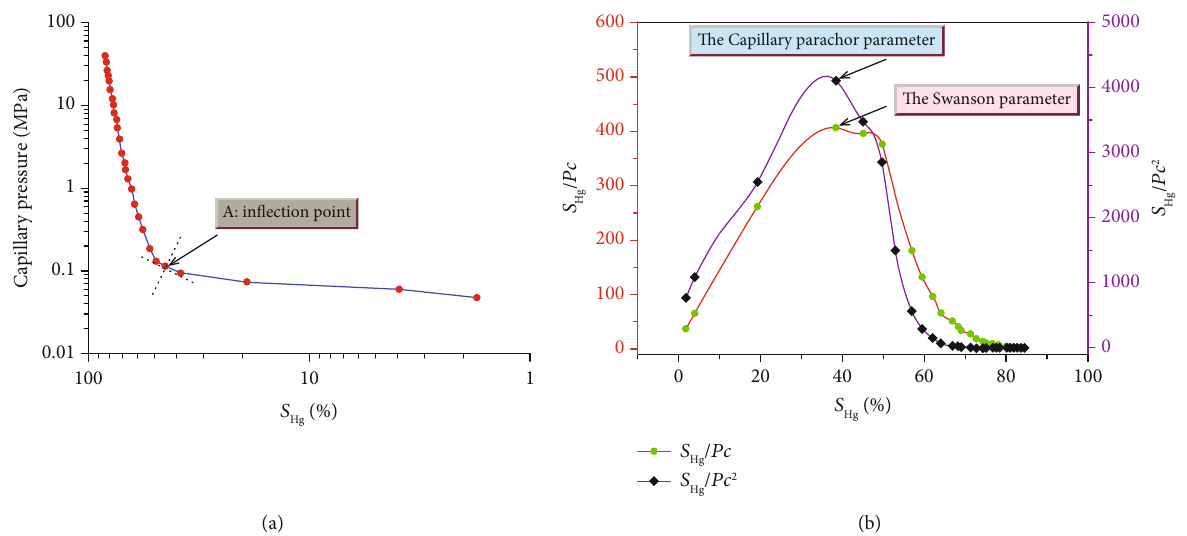
Figure 1: Mercury injection capillary pressure (MICP) curves (a) and corresponding Swanson and capillary parachor parameters for one core sample